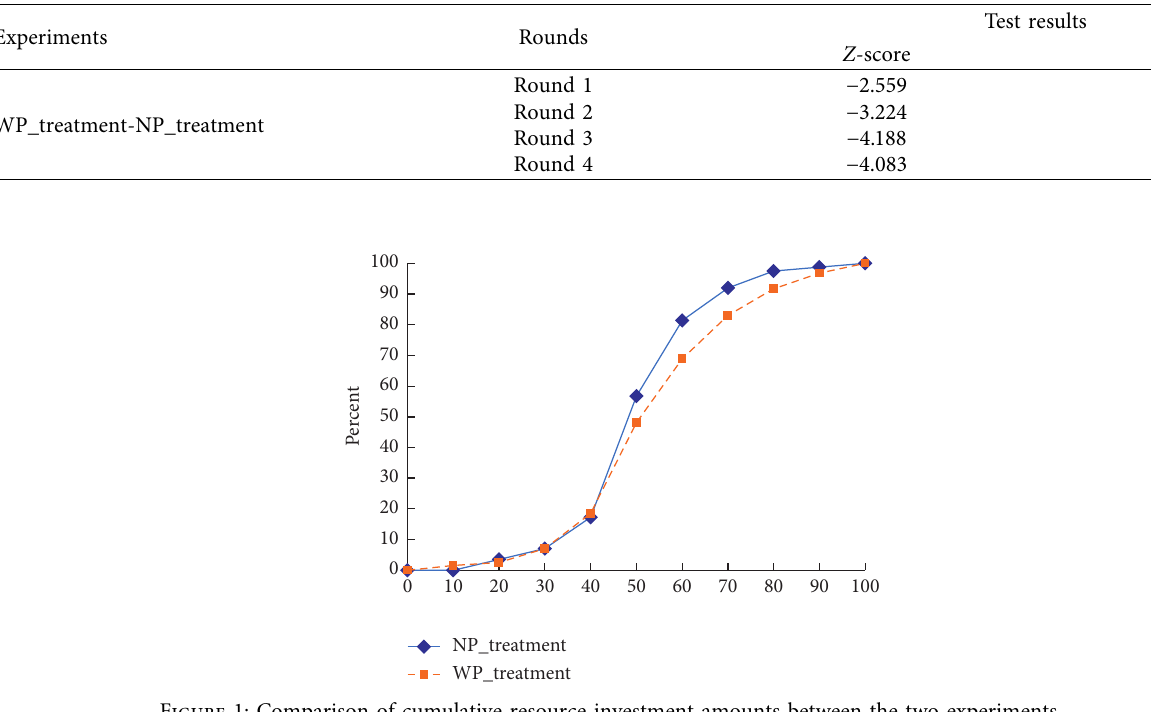
Table 2: Mann–Whitney U test results on the resource investment rates in different rounds